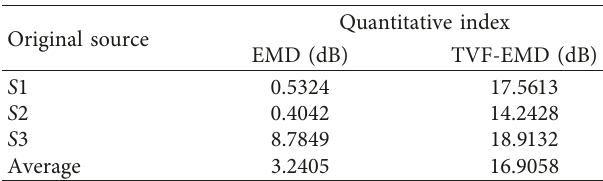
Figure 3: The calculation results by the TVF-EMD method. Table 1: Quantitative index on the performance of the EMD and TVF-EMD methods.